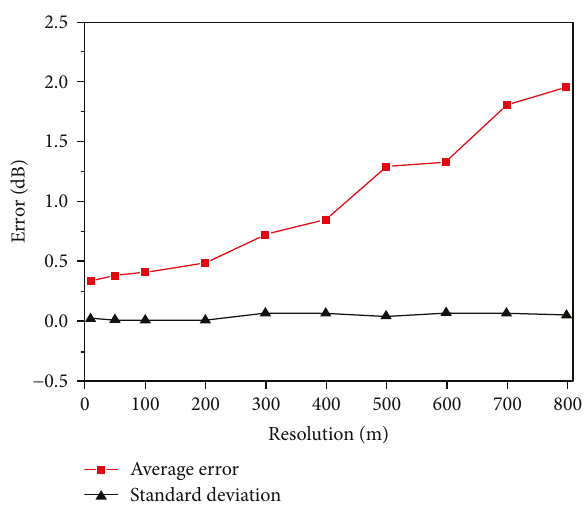
Figure 7: Average error and standard deviation versu